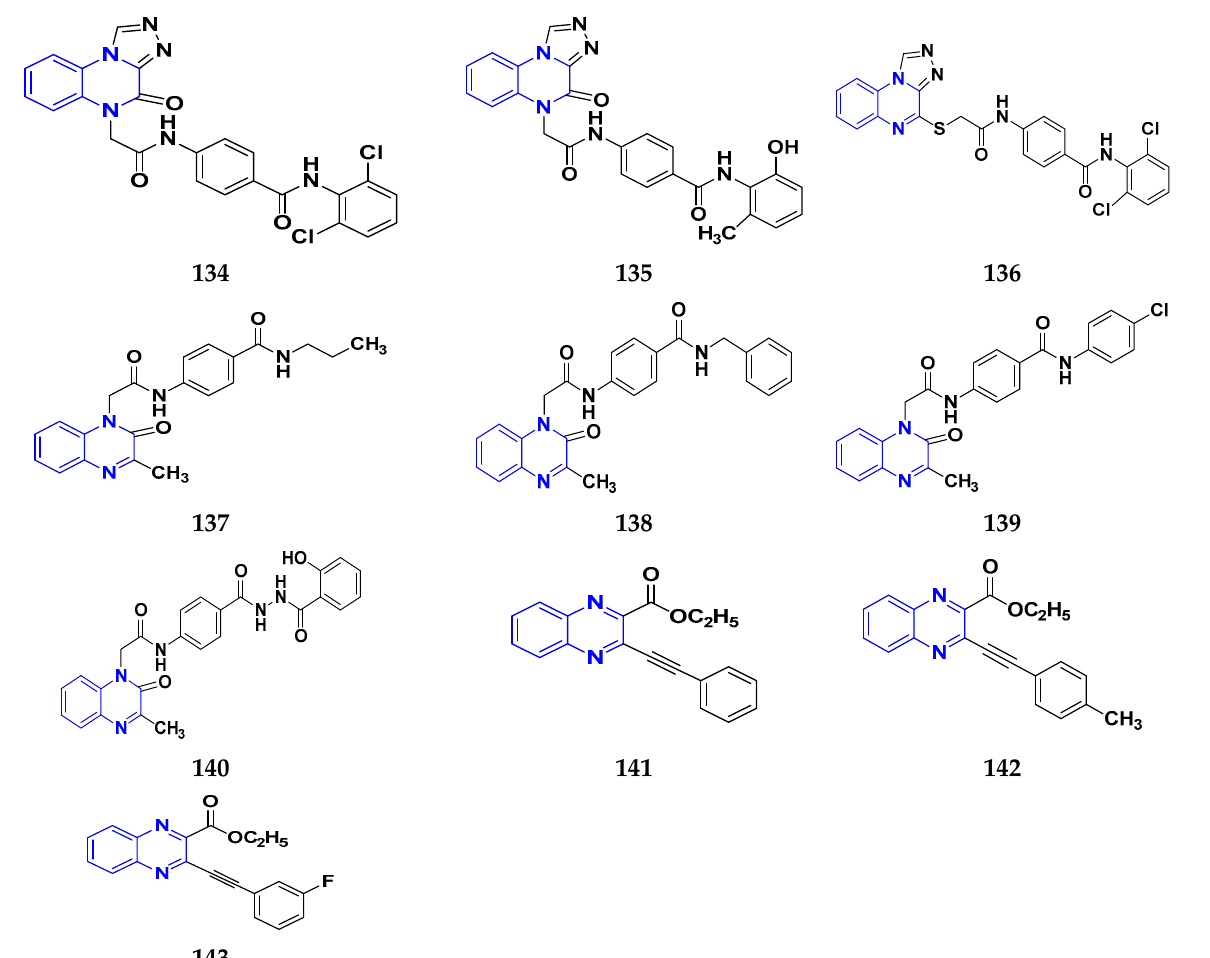
Figure 14. Quinoxaline derivatives ( 119 – 143 ) as anticancer agents.